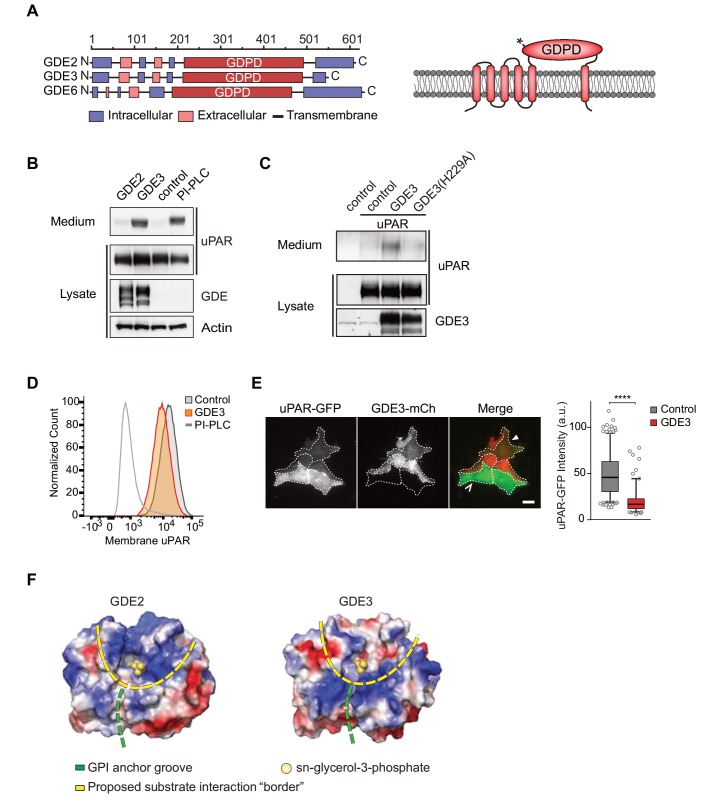
GDE3, but not GDE2, sheds uPAR from HEK293 cells.(A) Domain structure of GDE2, GDE3 and GDE6 (left panel), and the transmembrane scheme of GDE3 (right panel). GDPD denotes catalytic glycerophosphodiesterase domain. Asterisk in GDPD domain depicts catalytic His residue in both GDE2 and GDE3. (B) Immunoblot analysis of uPAR release into the medium. HEK-uPAR cells transfected with empty vector (control), GDE2 or GDE3. PI-PLC served as positive control. (C) Mutant GDE3(H229A) fails to release uPAR. (D) Partial loss of uPAR from the plasma membrane by GDE3, as measured by flow cytometry. (E) TIRF microscopy reveals loss of uPAR from the basolateral plasma membrane. Box plot shows uPAR-GFP intensity at the ventral membrane (n = 3, mean ±SEM ****p<0001). (F) Homology modeling of the GDE2 and GDE3 catalytic domains showing surface charge distributions (blue, positive; red, negative; green line, putative GPI-binding groove; yellow line, proposed substrate-binding surface). The active site is indicated by glycerol-3-phosphate located at the template structure.